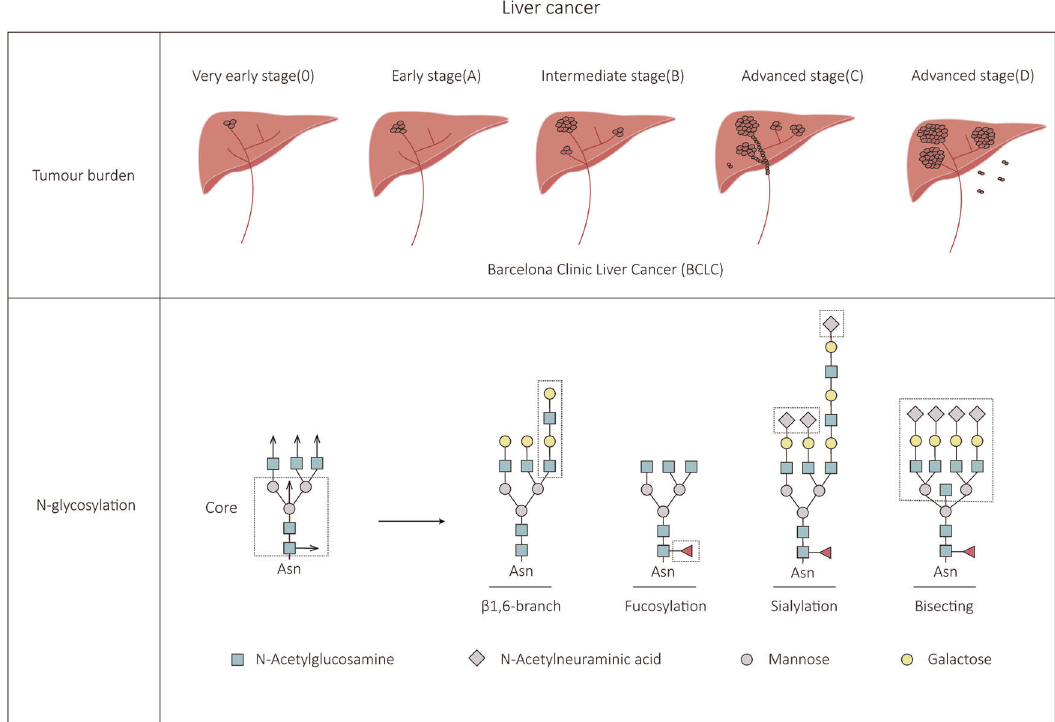
Fig. 2 Schematic diagram of liver cancer progression and associated N-glycan type changes. Barcelona Clinic Liver Cancer (BCLC) is the most widely used clinical liver cancer staging system, which divides liver cancer into three stages, early (0/A), intermediate (B), and advanced (C/D), mainly based on the patient ’ s tumor status and liver function. N-glycan chains can participate in cell recognition, signal transduction, immune responses, and other life activities. Compared with normal cells, tumor cells, such as HCC cells, often exhibit abnormal changes in N-glycan conformation, such as abnormal branching chains and bisecting structures and altered levels of fucosylation and